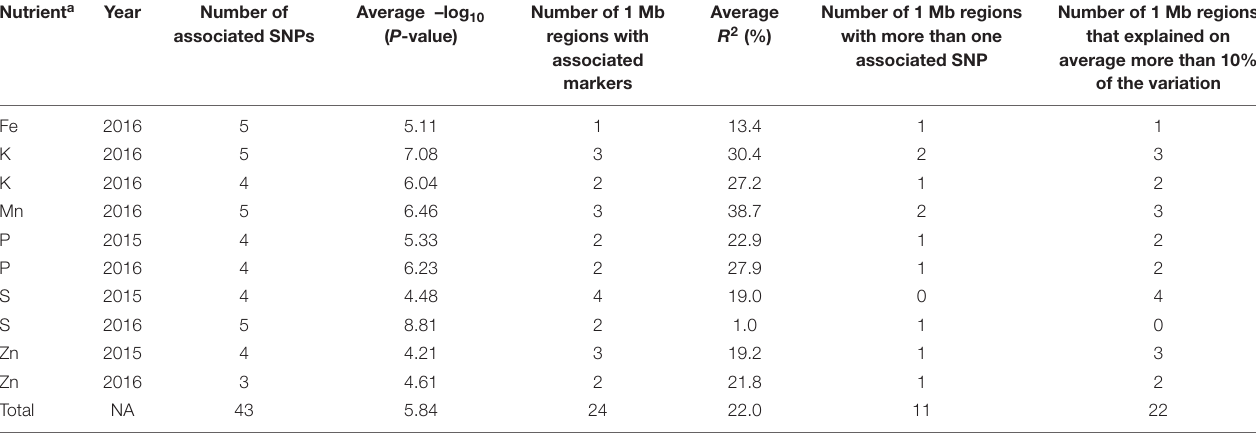
Results are from the optimum genome-wide association analyses and regions are defined by 1 Mb sequences that flanked associated markers. a Cases for which there were no associated markers (Ca measured in 2016 and 2017, Fe measured in 2016 and Mn measured in 2016) are not in this table but are found described in Supplementary Figures S1, S2, S4